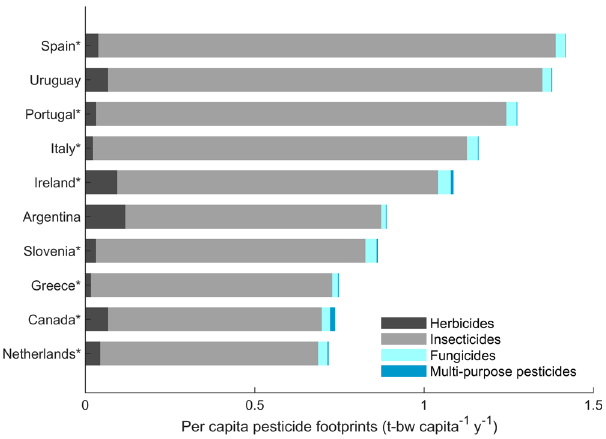
Fig. 2 Top 10 countries with the highest per-capita pesticide footprints embedded in their consumption. *Developed and economies in transition countries. Broad regions are not included in this plot but are represented in Supplementary Fig.